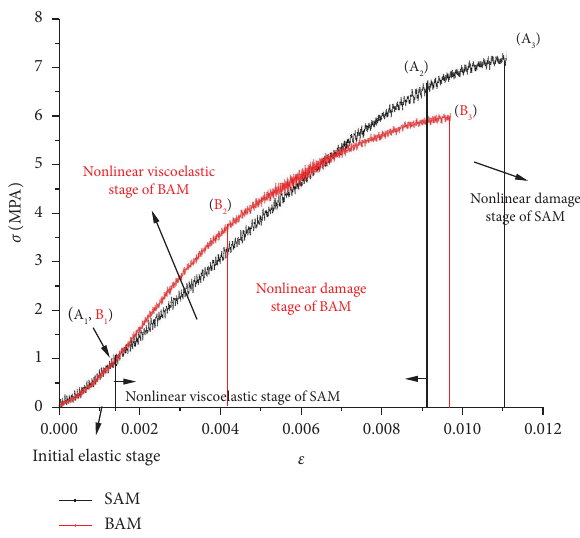
Figure 7: Stress and strain of SAM and